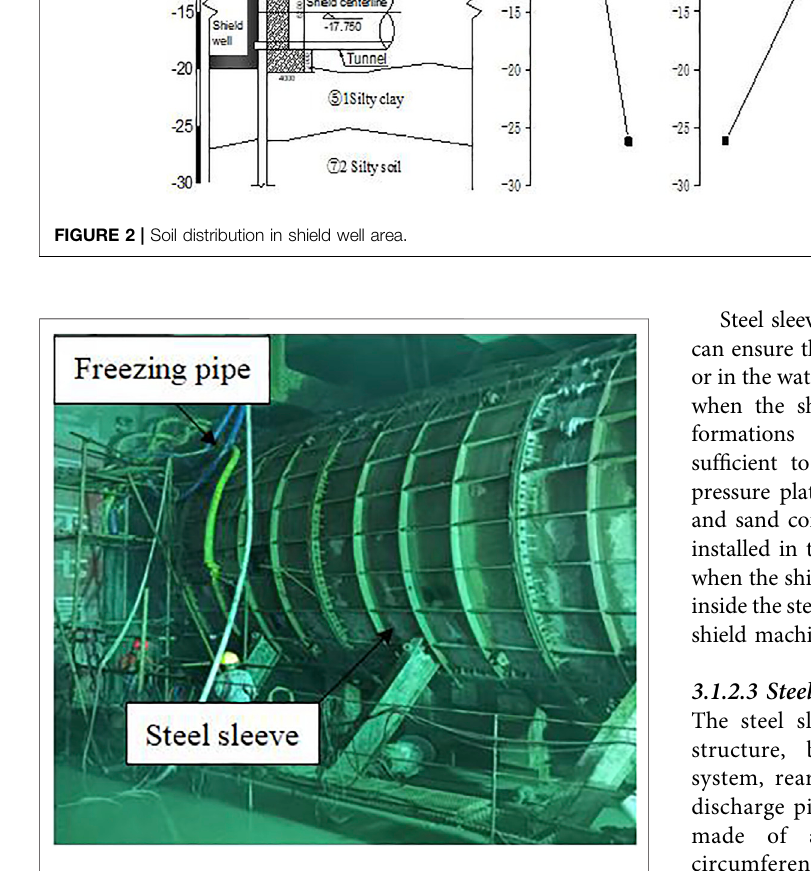
FIGURE 3 | In site freeze pipes at the shield machine launching